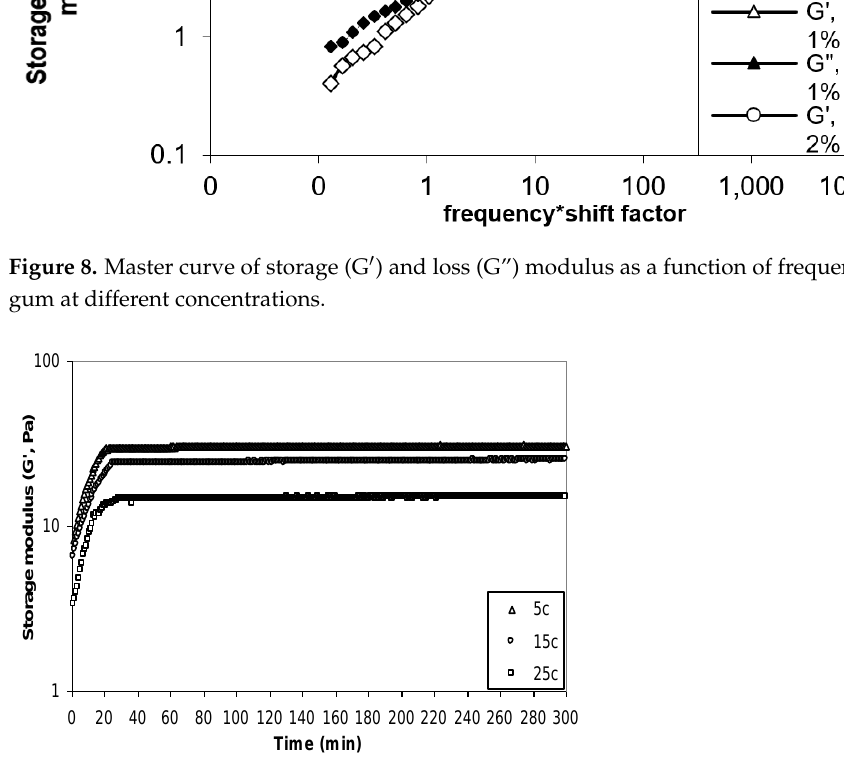
Figure 10. Cox-Merz plot of steady shear (closed symbol ) and dynamic (open symbol ) viscosities for 0 . 5, 1 . 0 and 2 . 0% Yanang gum.